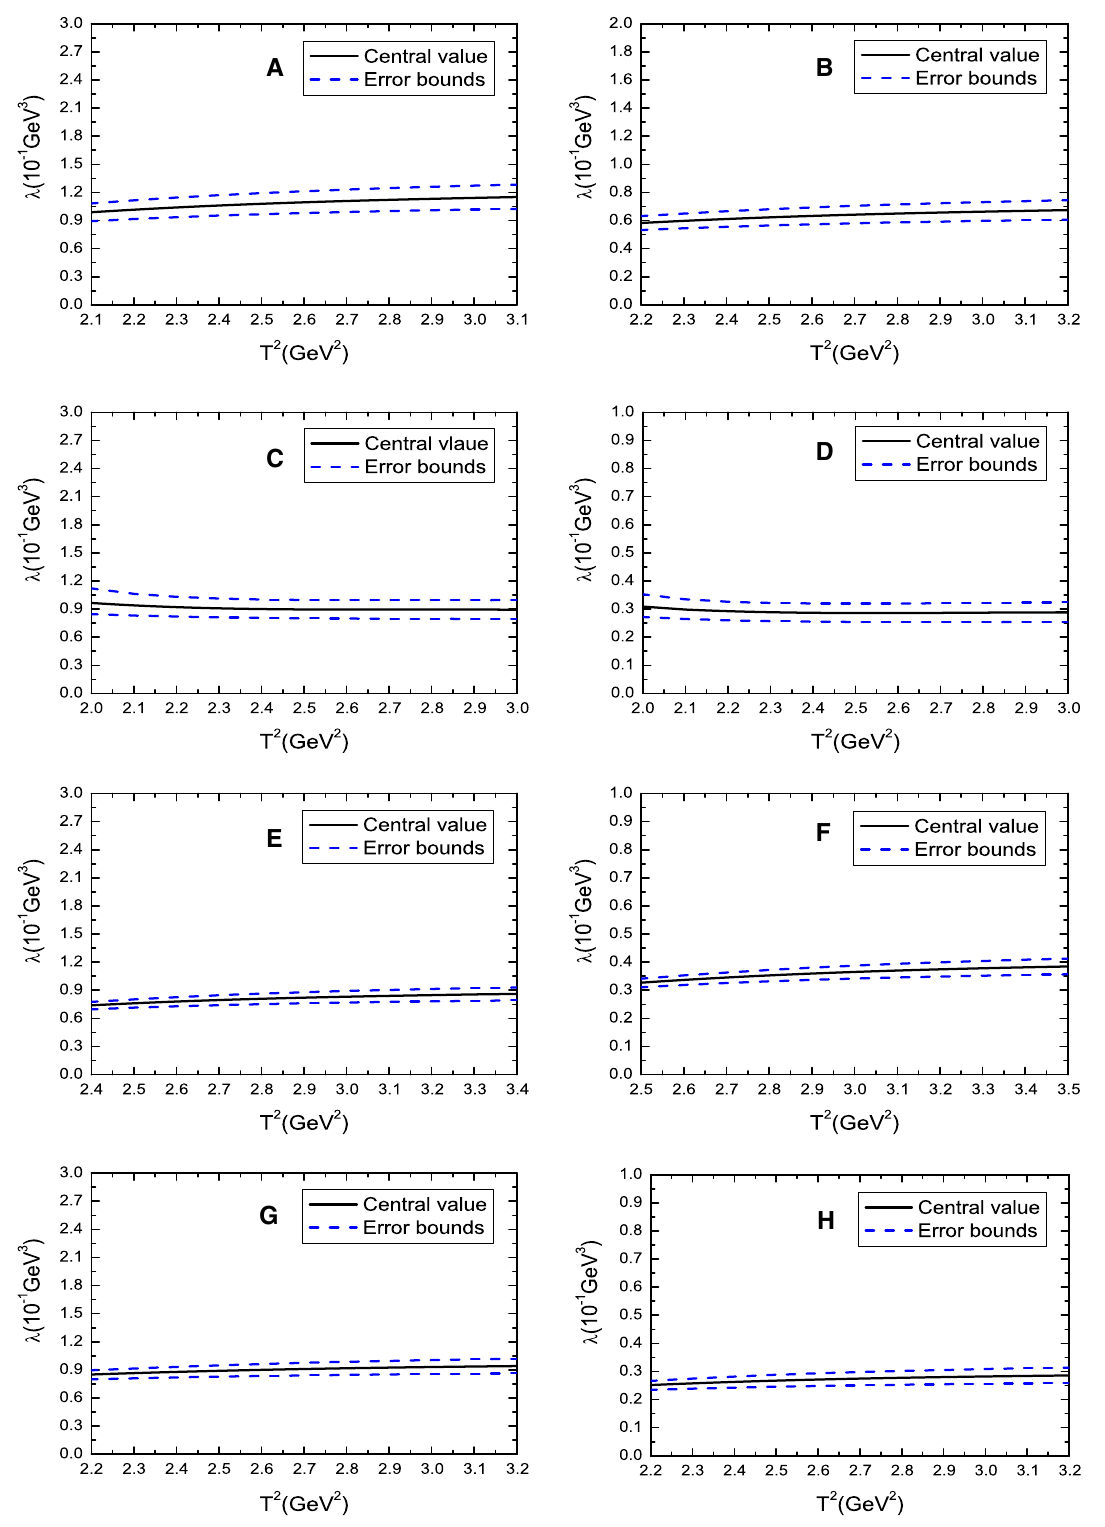
Fig. 4 The pole residues of the (cid:2) c states with variations of the Borel parameters T 2 , where A , B , C , D , E , F , G and H correspond to the (cid:2) c states with the quantum numbers ( 1S , 1